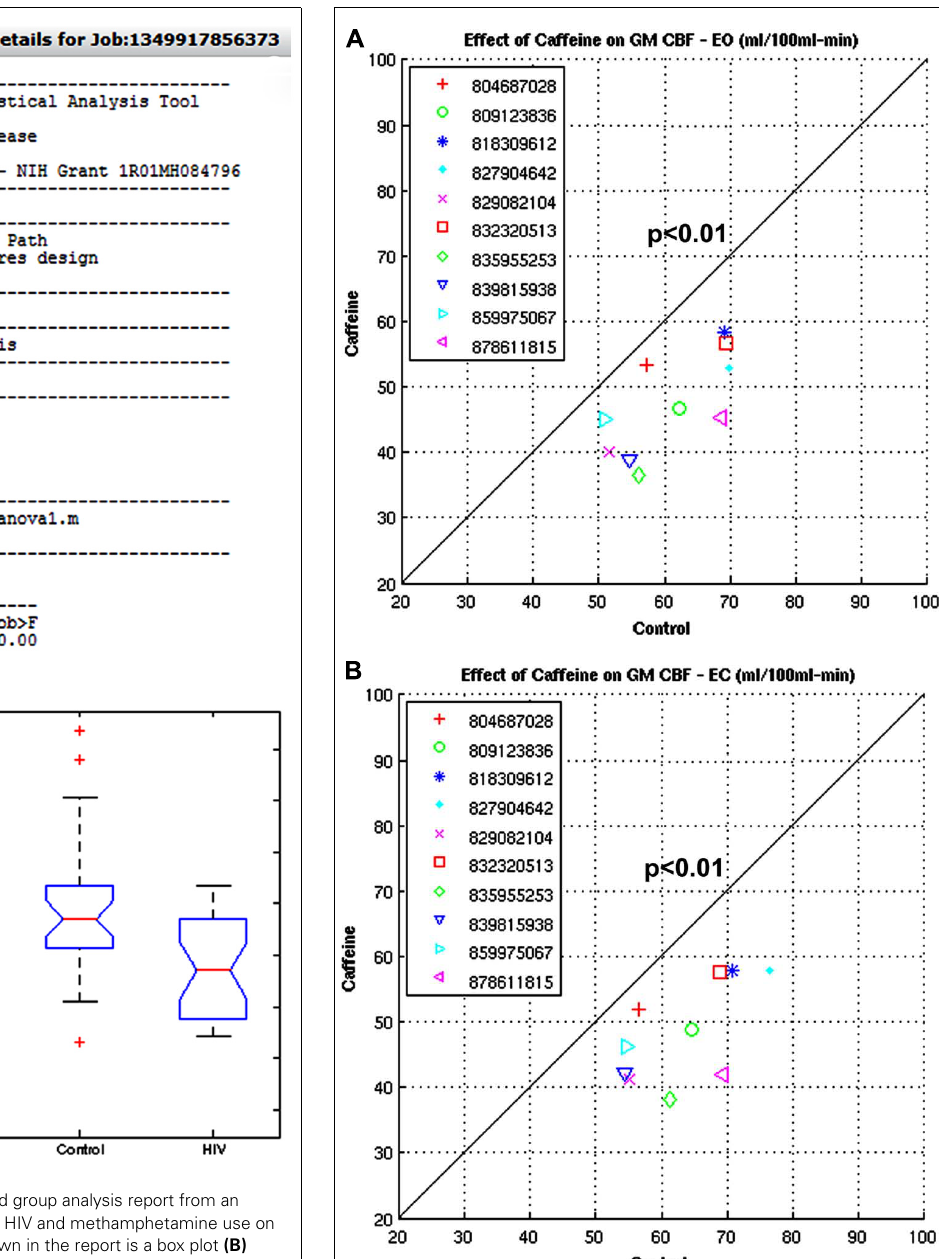
FIGURE 13 | (A,B) Plots from a study looking at the whole-brain gray matter CBF measures before and after caffeine consumption involving 10 healthy volunteers under EO and EC